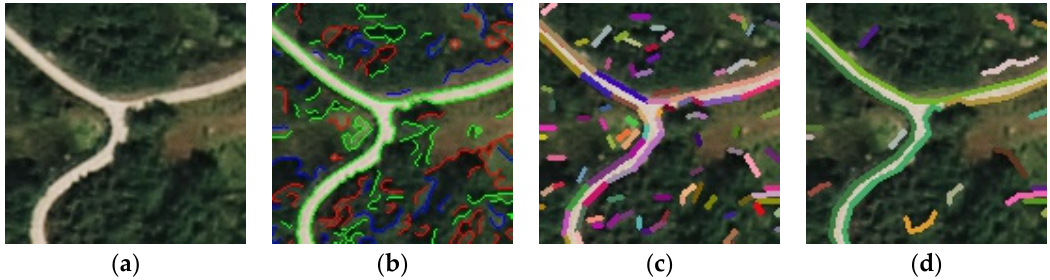
Figure 2. Line sequence extraction different steps result image. ( a ) Original image; ( b ) edge image; ( c ) line segment extraction result; ( d ) line sequence extraction